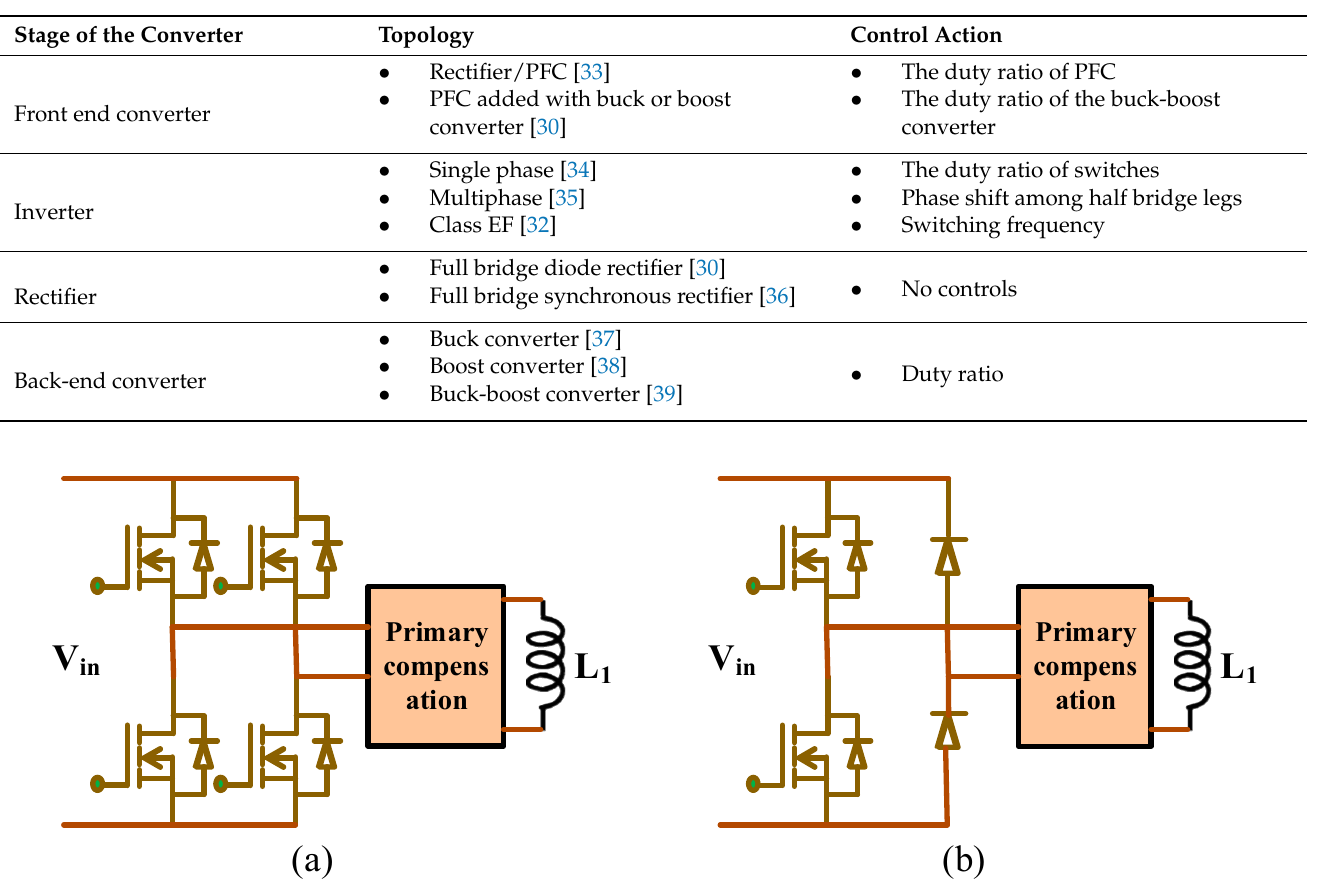
Figure 4. Block diagram of typical grid-to-vehicle WPT: ( a ) static WPT and ( b ) dynamic WPT.